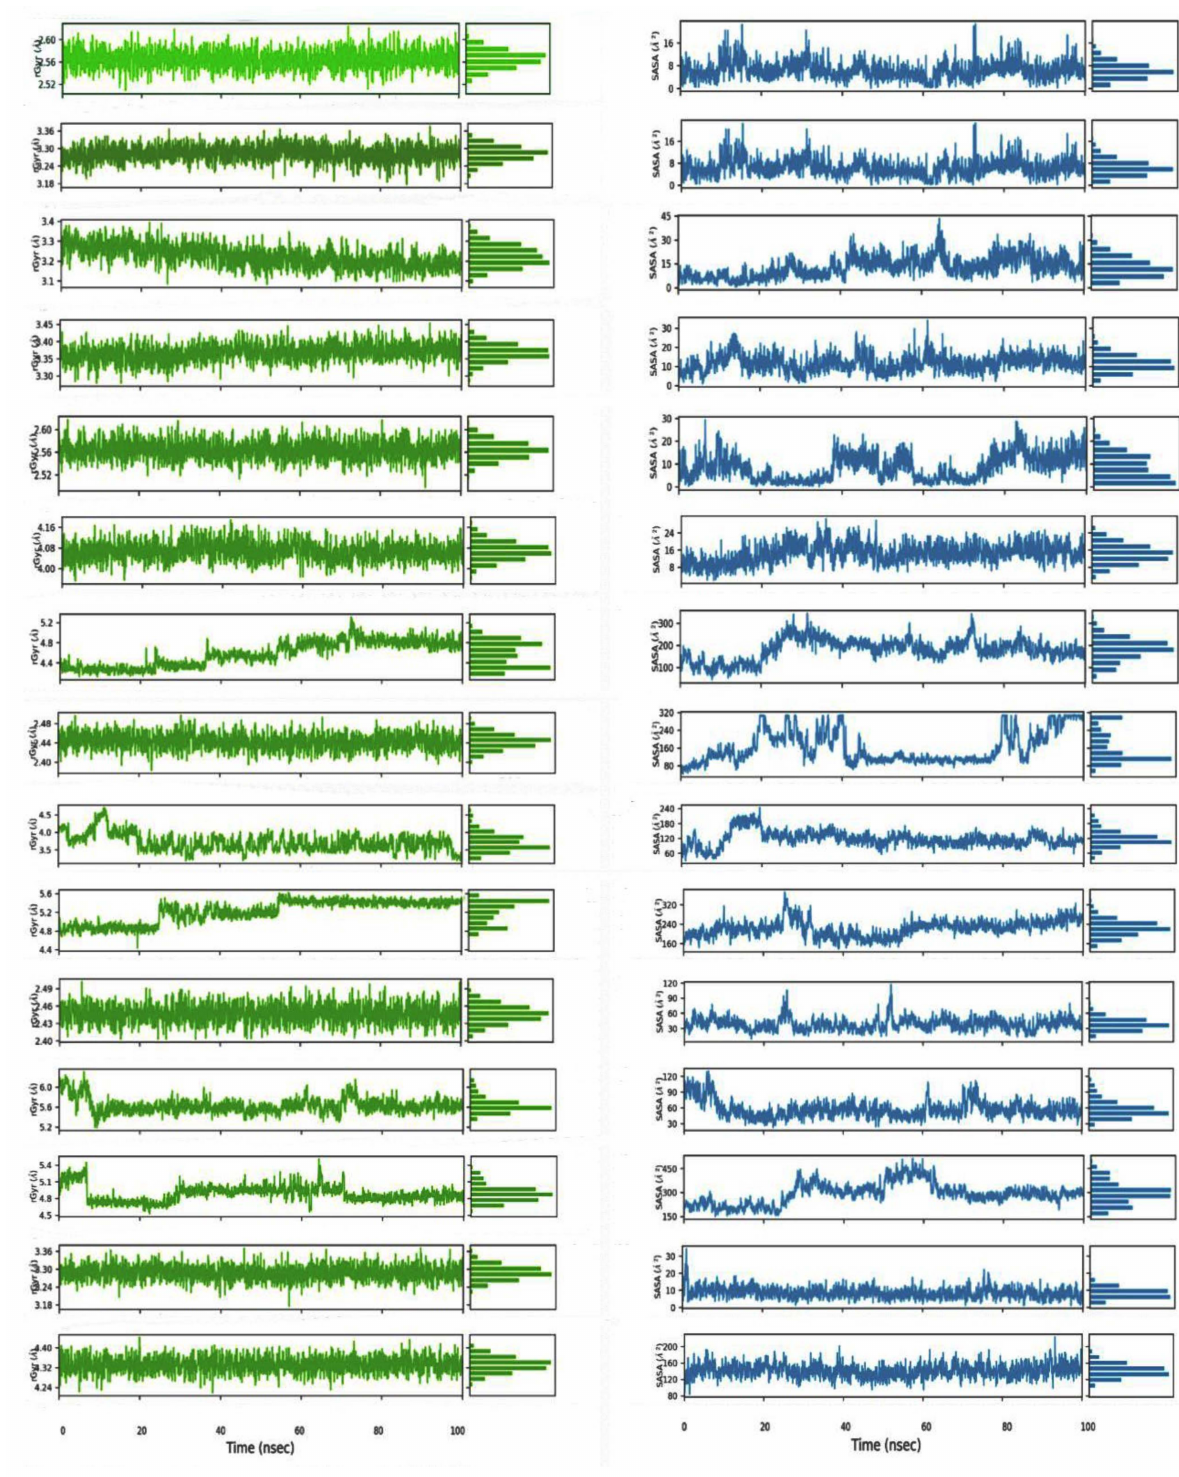
Figure 8. Ligand extendedness and accessible surface area by a water molecule through the 100 ns simulation production. Left column represent the radius of gyration (rGyr) data and right column exhibit the solvent accessible surface are (SASA) of the top two selected compounds and controls. The graphs are arranged in a sequence (top to bottom) for COX-1, COX-2, LOX-5, EGFR, and